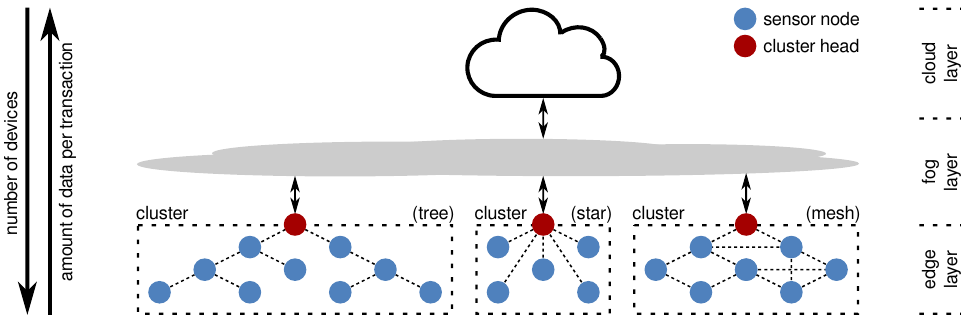
Figure 1. Architectural example of a clustered wireless sensor